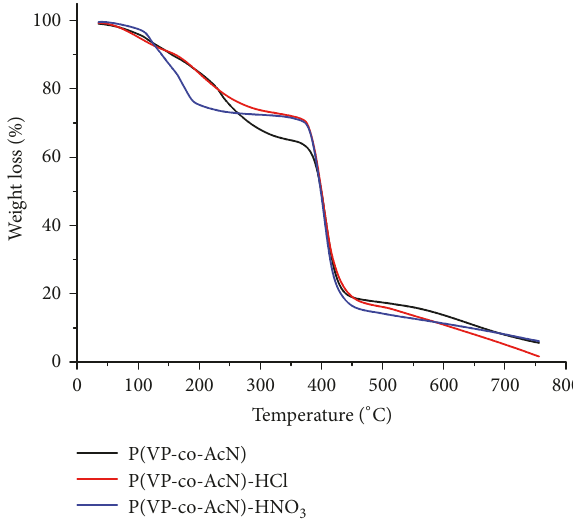
Figure 7: TGA spectra of the copolymer and the